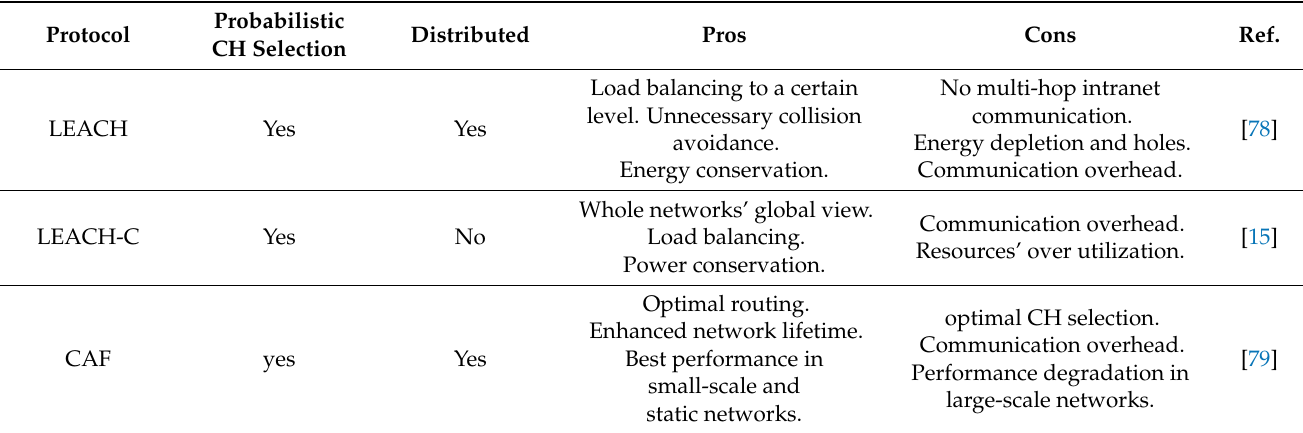
Table 4. Cluster-based protocols’